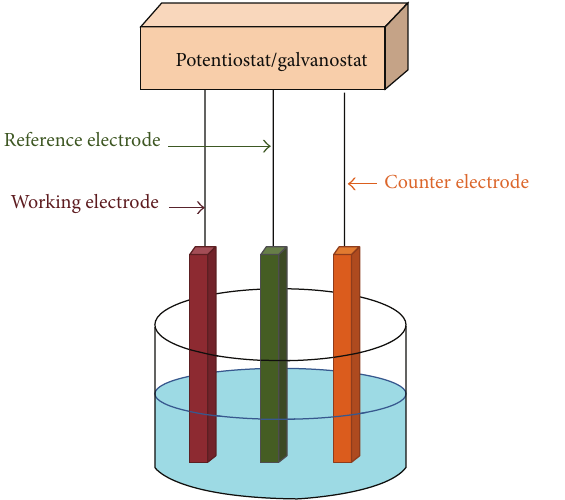
Figure 5: The schematic representation of the electrodeposition system [21].